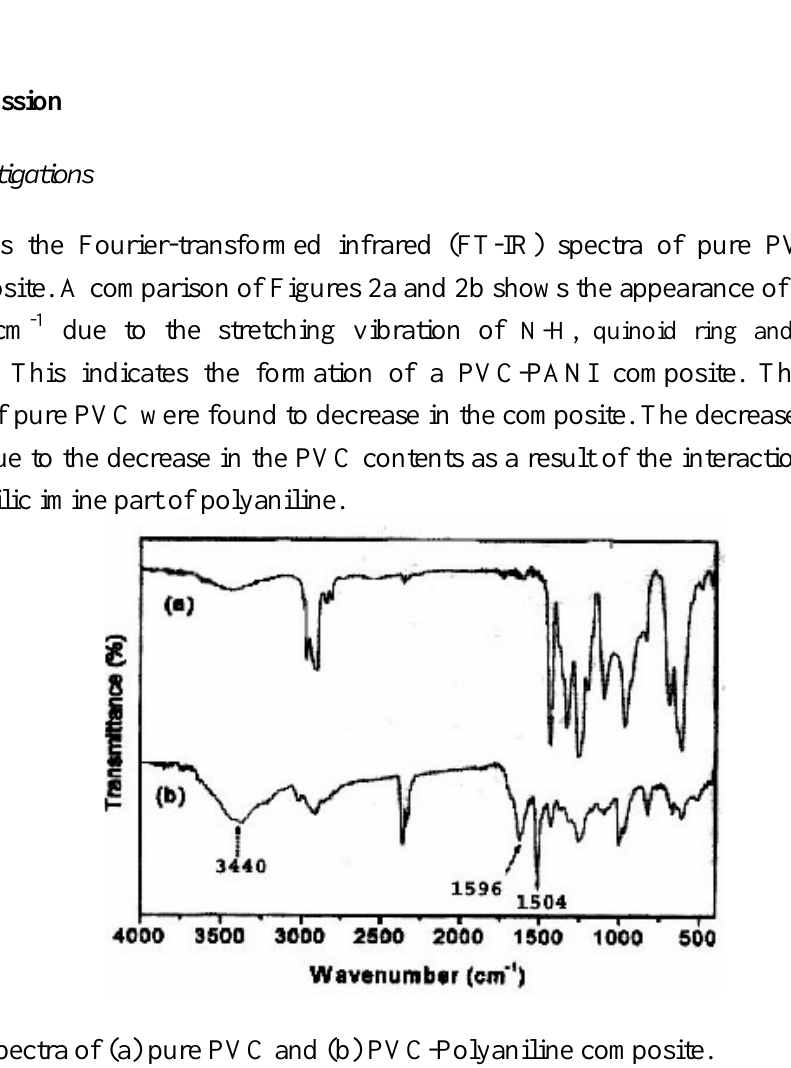
Figure 1. Schematic diagram of (a) electrode and (b) experimental setup used for sensitivity measurements.